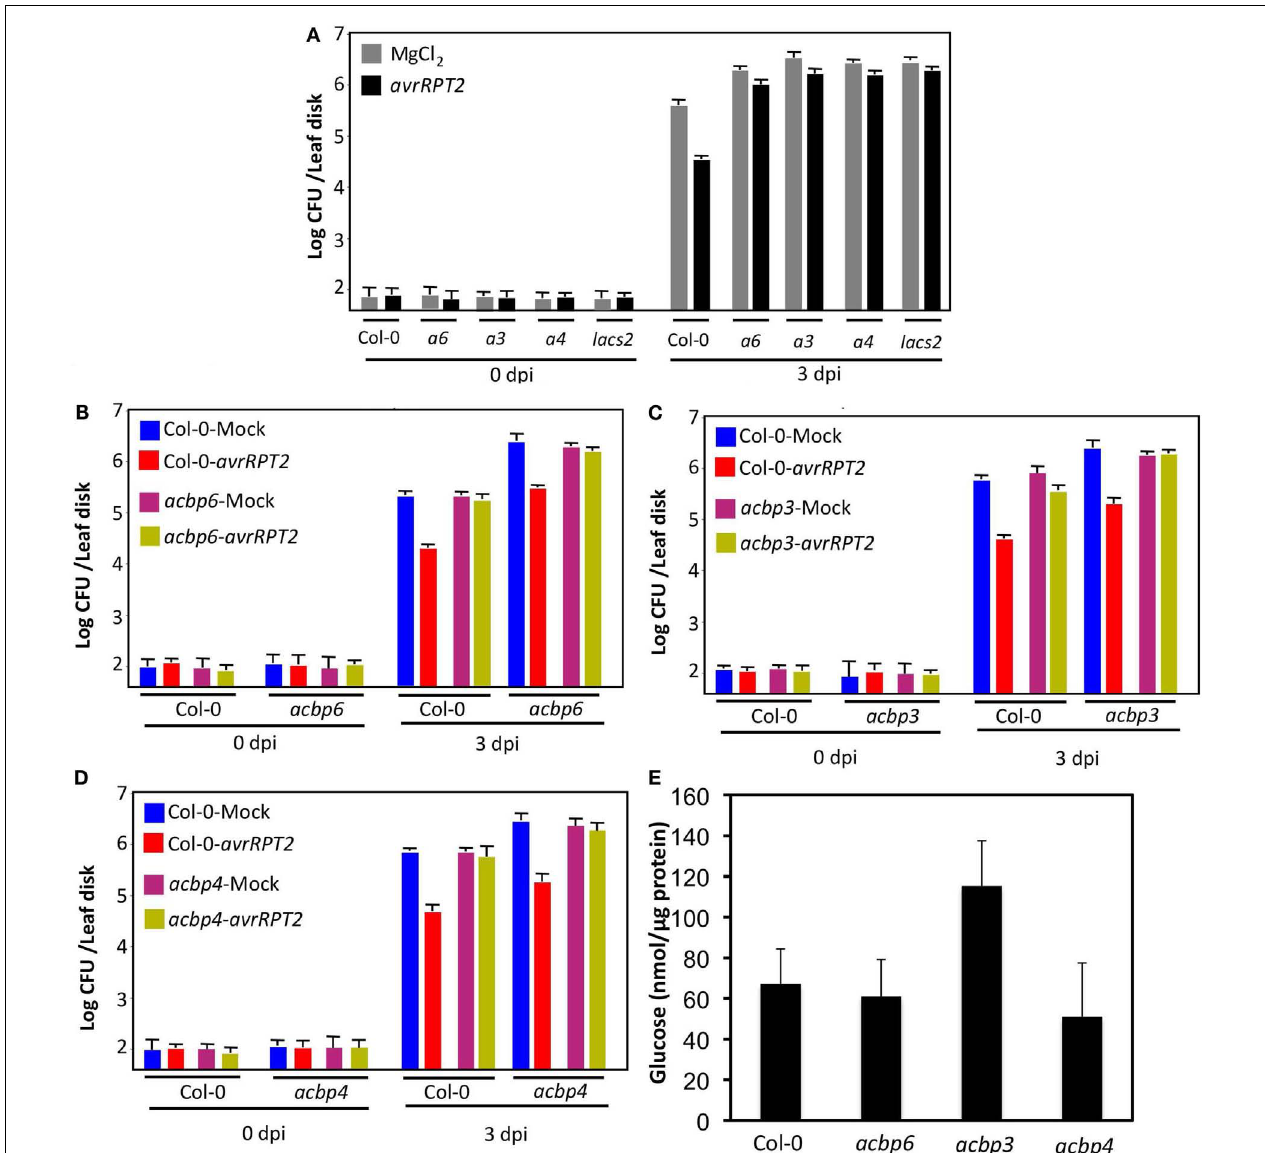
were treated either with MgCl 2 (blue and pink bars) or P. syringae expressing avrRpt2 (red and yellow bars). Error bars indicate SD ( n = 4). Statistical significance was calculated using Student’s t -test ( P < 0.0001). Experiments shown in (B–D) were repeated twice with similar results. Bacterial growth presented as the LOG of colony forming units (CFU) per leaf disk, was monitored at 0 and 3dpi. (E) Glucose levels in petiole exudates collected from indicated genotypes. Error bars indicate SD.The experiment was repeated twice and the second repeat showed wild-type-like glucose levels in acbp3 plants. Error bars indicate SD ( n = 3). No statistical significance was observed in the levels from different genotypes per Student’s t